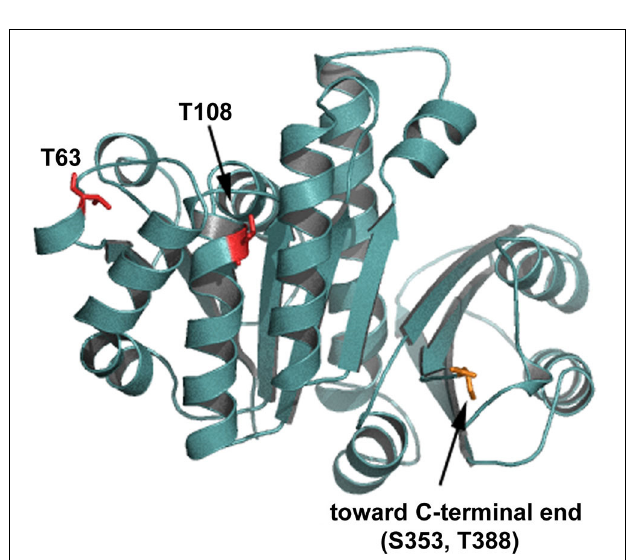
FIGURE 2 | Putative PknA phosphorylation sites on FtsZ. Shown is a homology model of C. glutamicum FtsZ. The residues phosphorylated by Ser/Thr protein kinases are shown in red and indicated. Residue T108 is involved in nucleotide binding/hydrolysis, T63 is at the interface of the FtsZ oligomerization domain. Residues S353 and T388 are located toward the C-terminal end. The C-terminal end is not depicted in this